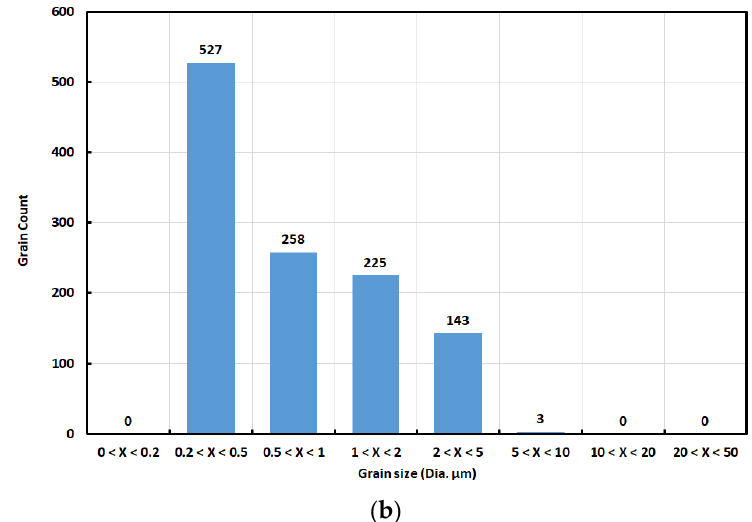
Figure 12. Grain size at ( a ) and area distributions at ( b ) of heat-treated steel M9.8 sample. The histogram plot of M9.8WQ aged at 550 °C for 120 min is shown in Figure 13. The final microstructure includes small secondary Mo precipitates with a mean diameter of 19 ± 1 nm and narrower size distribution, as seen in Figure 13. In conclusion, Mo-rich phase precipitates are found in this sample, with distinctly different sizes. In this sample, no Laves precipitate (Mo, Cr) is observed after austenisation, and only after aging do the small secondary Laves phase precipitates form in the microstructure, located both within the martensite laths and along the lath boundaries.